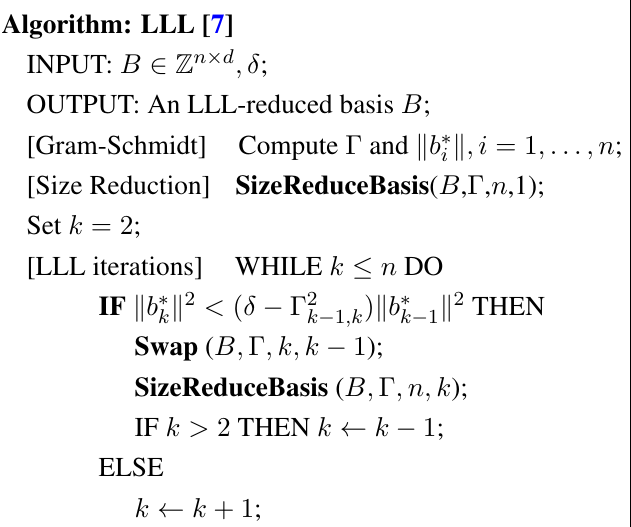
Figure 3. The LLL Basis Reduction Algorithm.